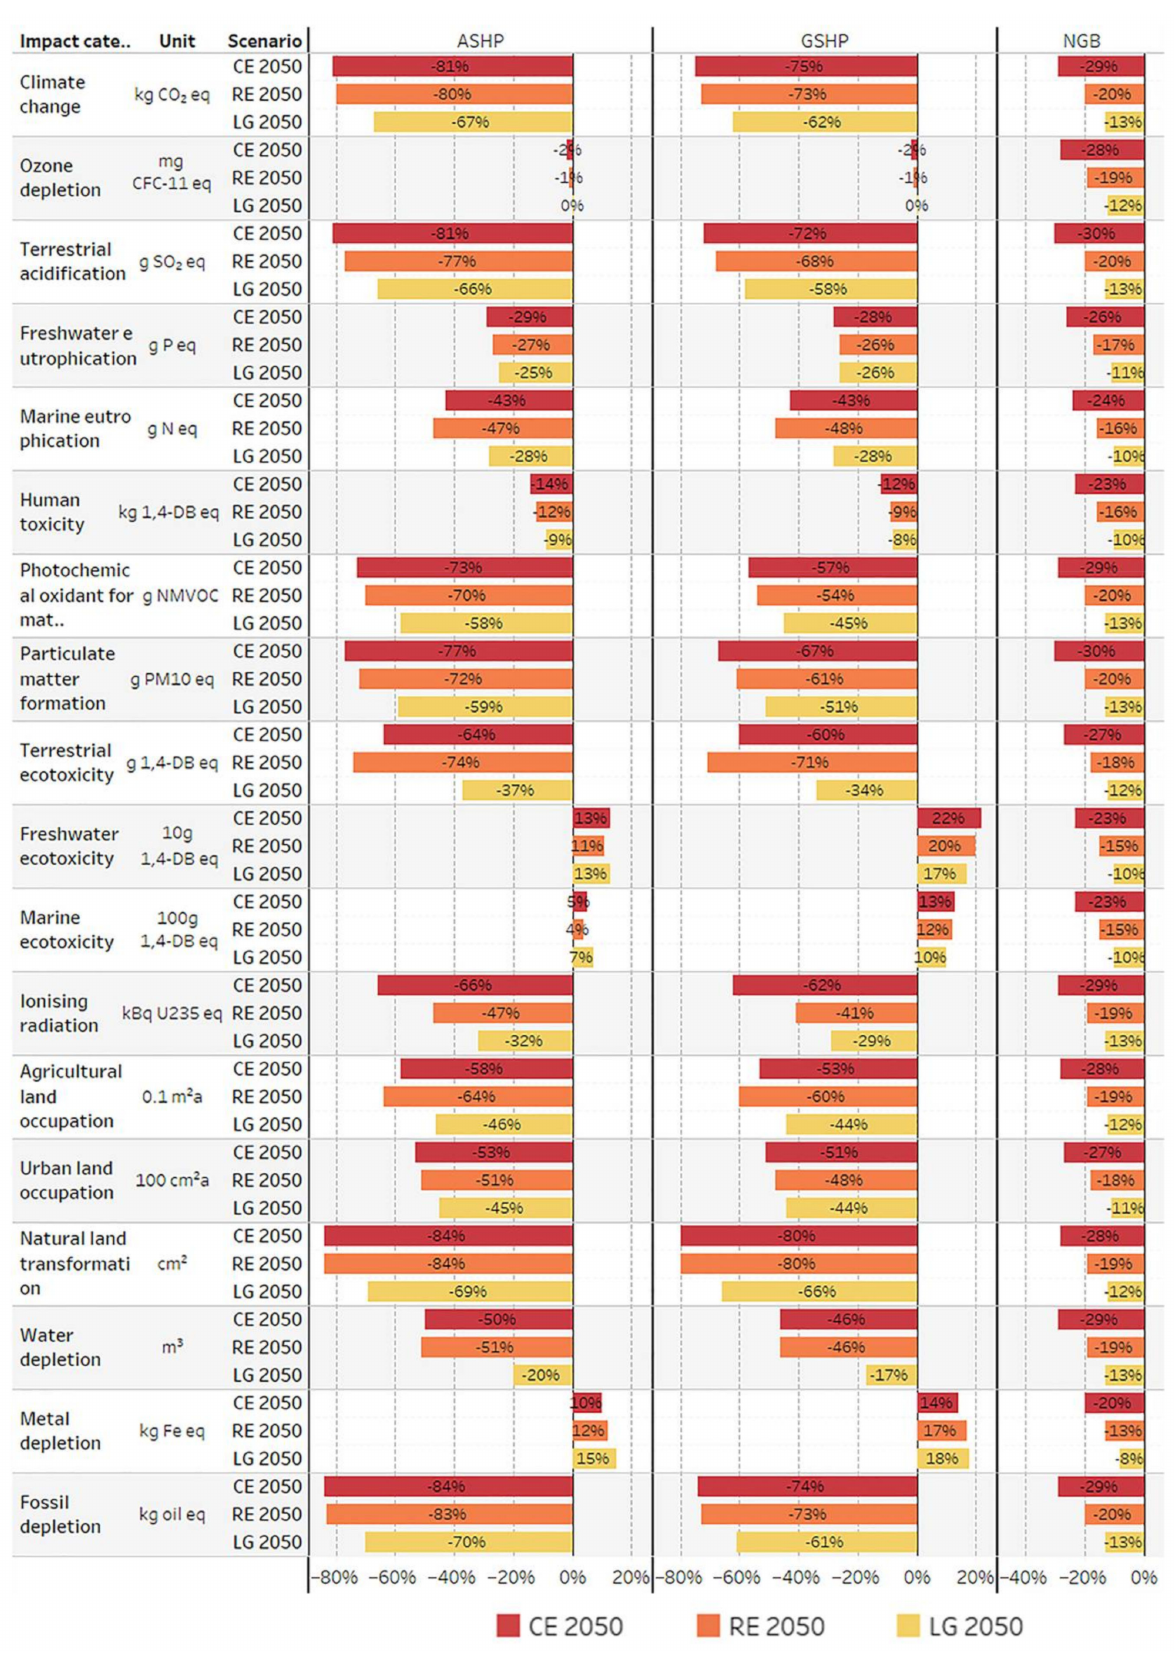
Figure 3. Lifecycle environmental impact change of future scenarios according to the baseline